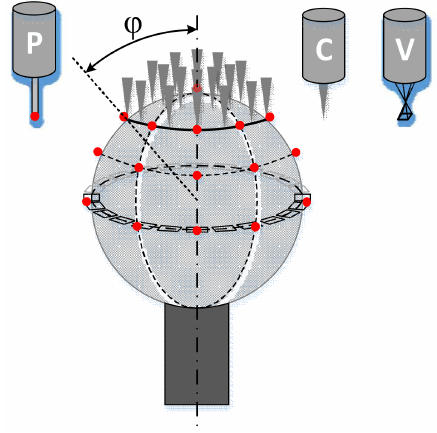
Figure 2. A reference sphere for multi-sensor registration.